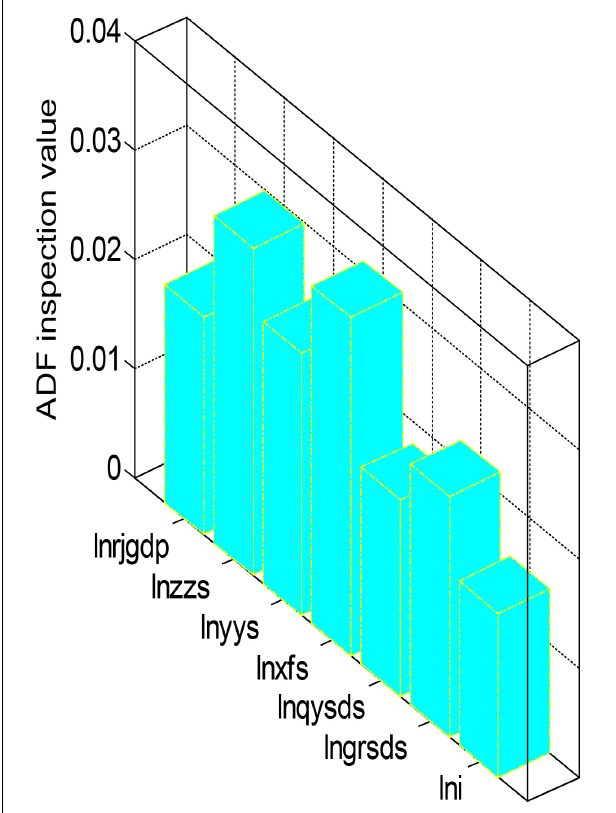
FIGURE 6 | ADF unit root stationarity test